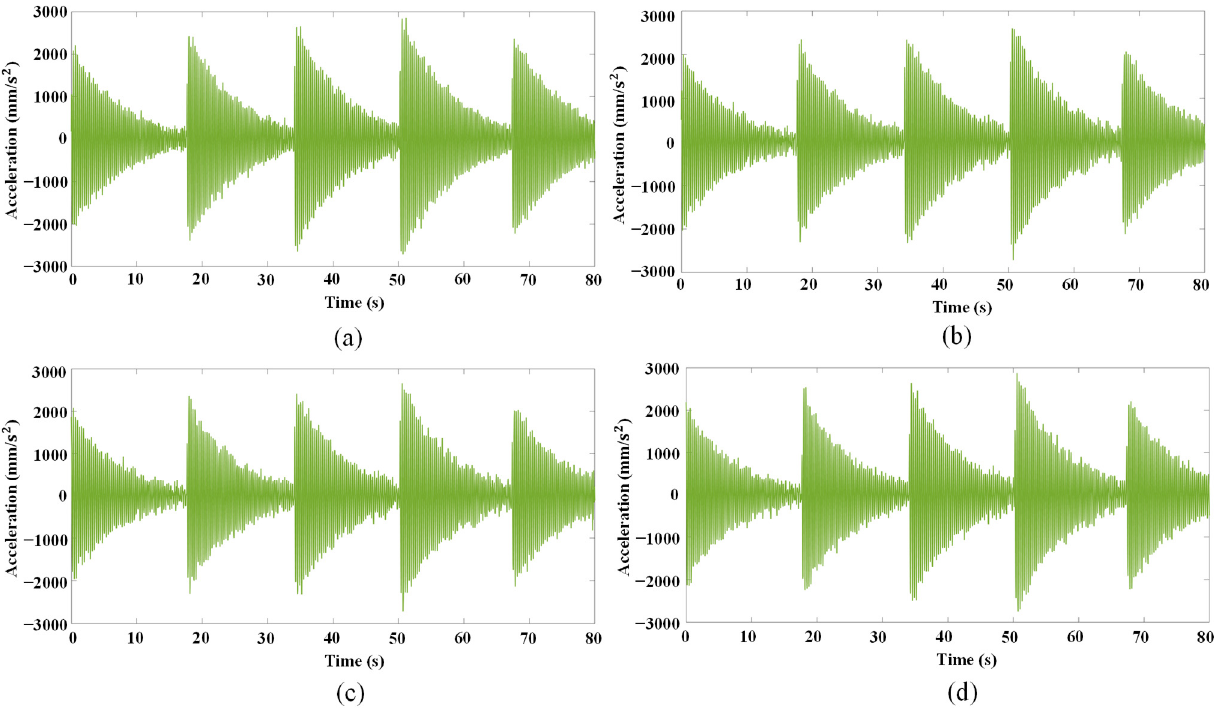
Figure 14. Acceleration signals of four cases: ( a ) fixed camera; ( b ) EMD; ( c ) FT; ( d ) DF.